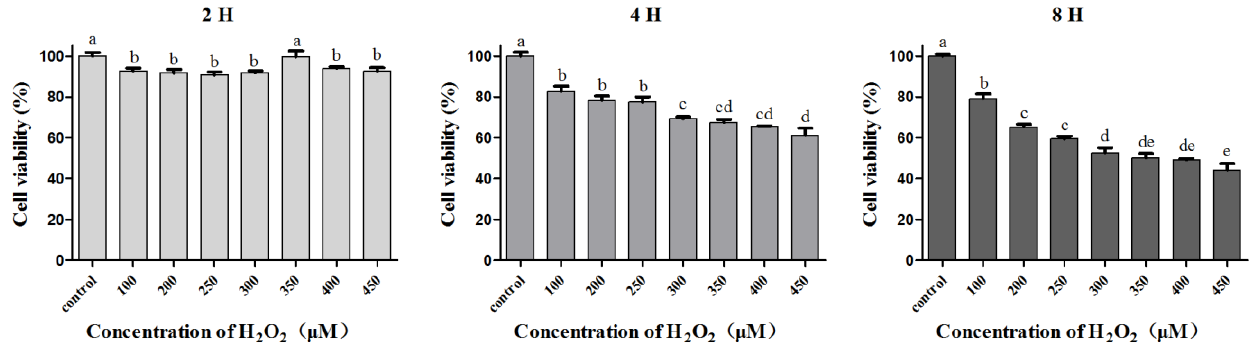
Figure 7. Effects of gradient concentrations and different treated times of H 2 O 2 on L02 cells. Data are expressed as means ± SD ( n = 3), and means labeled by different letters (a–e) were found to be significantly different at a level of p < 0.05 ( n = 3) by one-way ANOVA DMRT.